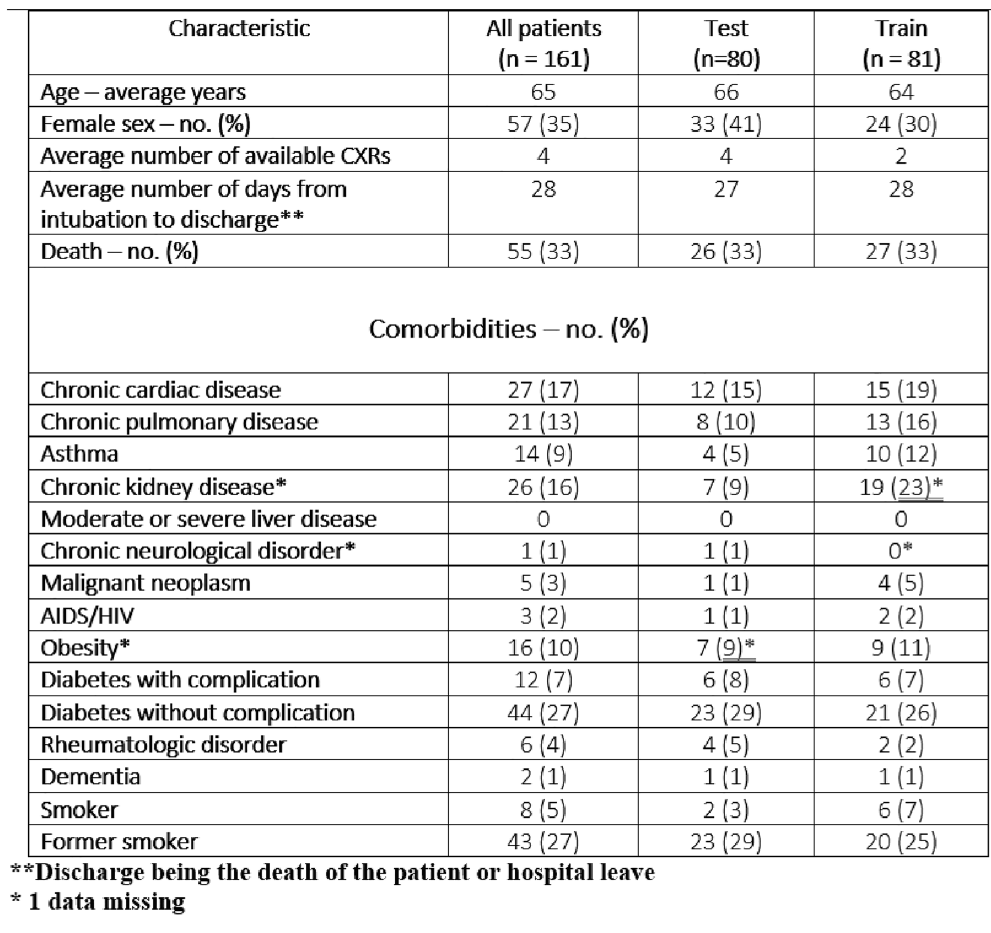
Figure 1. Training and testing set statistics. The * denotes a comorbidity where information about the comorbidity was not available for a single